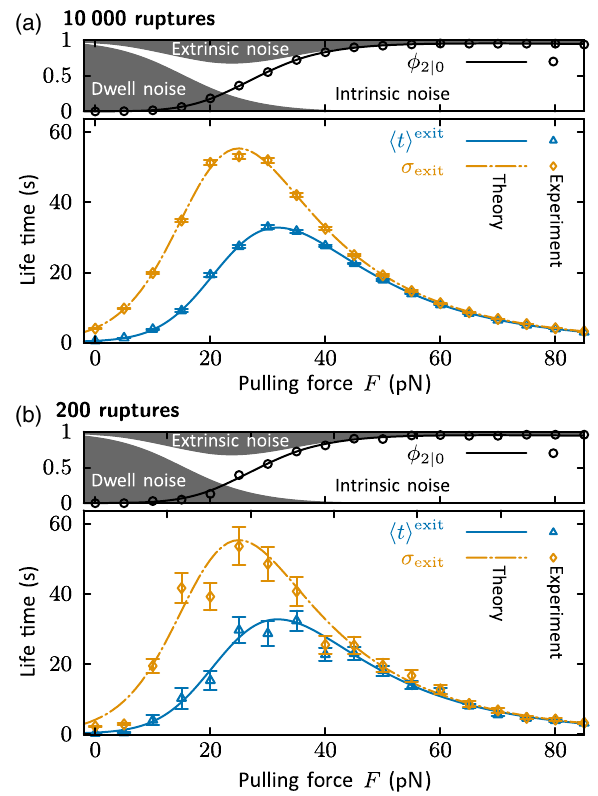
FIG. 17. Catch-bond analysis with improved statistics. The results for (a) 10 4 ruptures and (b) 200 ruptures. The error bars denote the standard deviation and the lines the theoretical results.